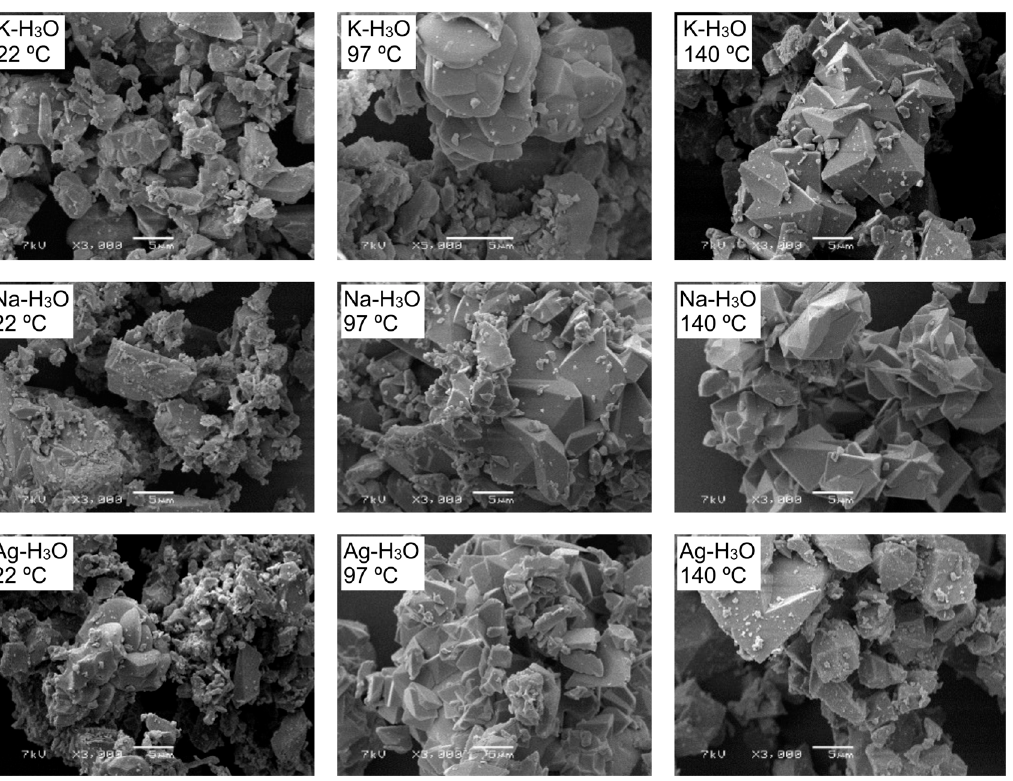
Figure 2. Photomicrographs of end-member K-H 3 O, Na-H 3 O and Ag-H 3 O synthesised at 22 °C, 97 °C and 140 °C.